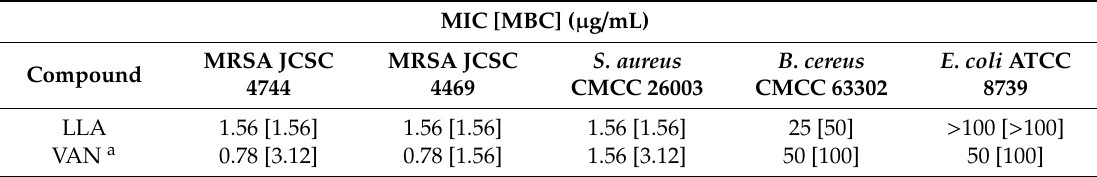
Table 8. Antibacterial activity of longistylin A (LLA) compared with vancomycin (VAN) from Wu et al. (2020) [69].